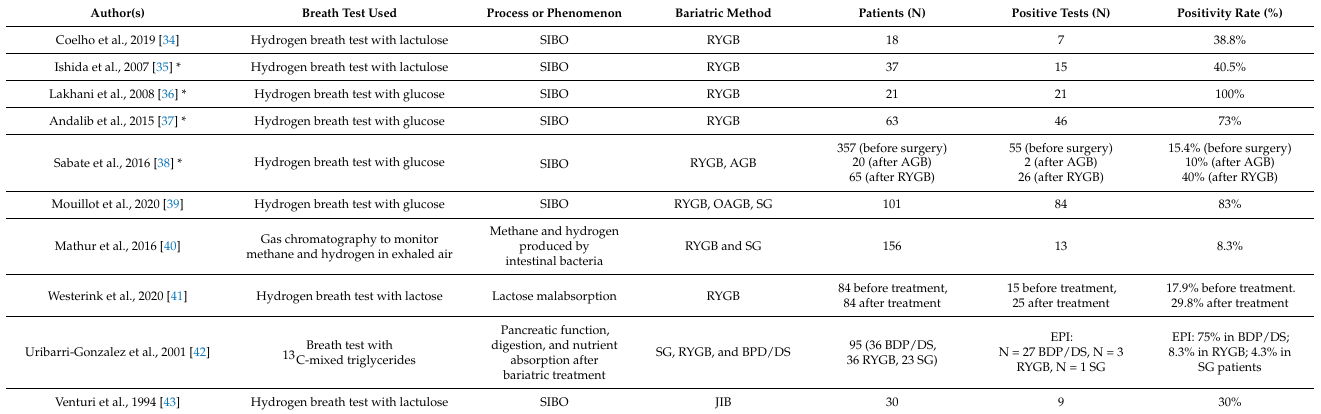
Table 2. Summary of studies on the use of breath tests in bariatrics between 1990 and